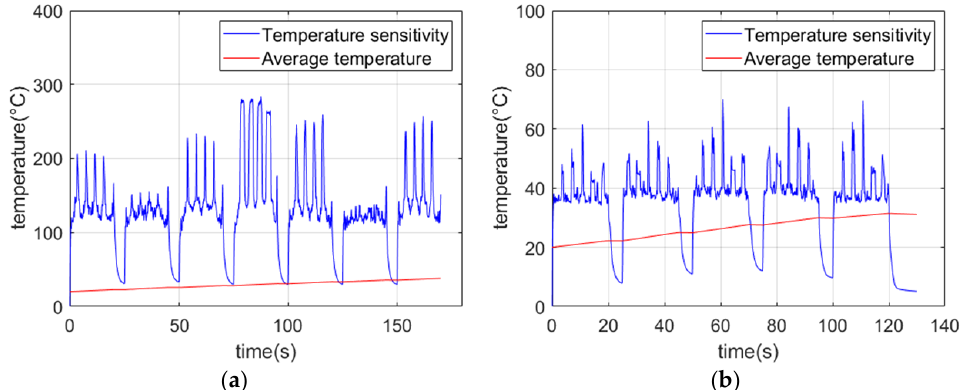
Figure 8. Temperature field versus time curve of carbon fiber surface: ( a ) temperature field changes along the z ‐ axis; ( b ) variation in temperature along the x ‐ axis.